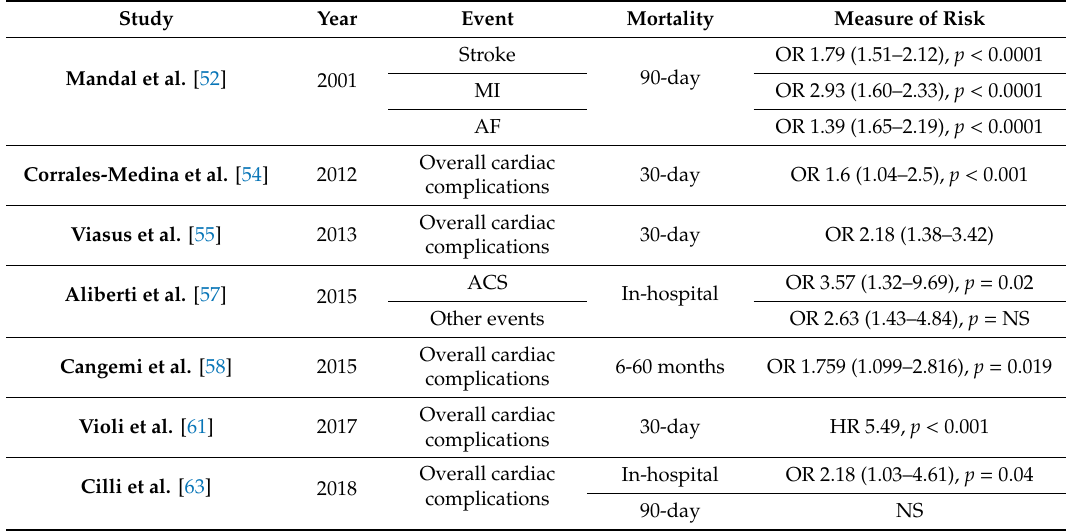
Table 3. Association of CV events and mortality after